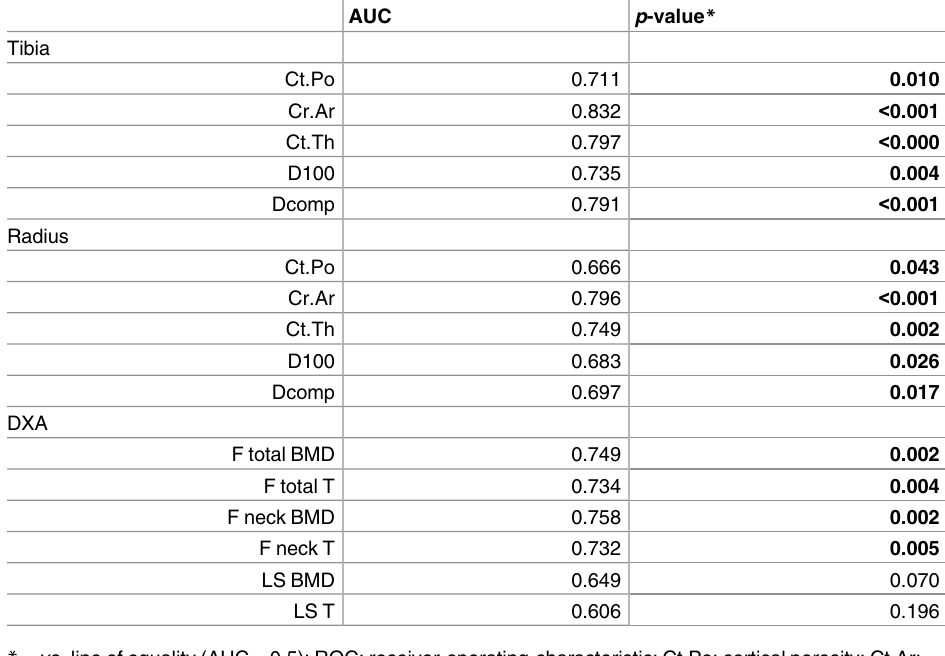
Table 4. ROC areasunder the curve (AUC) for HR-pQCT parameters including Ct.Po. AUC p -value * Tibia Ct.Po 0.711